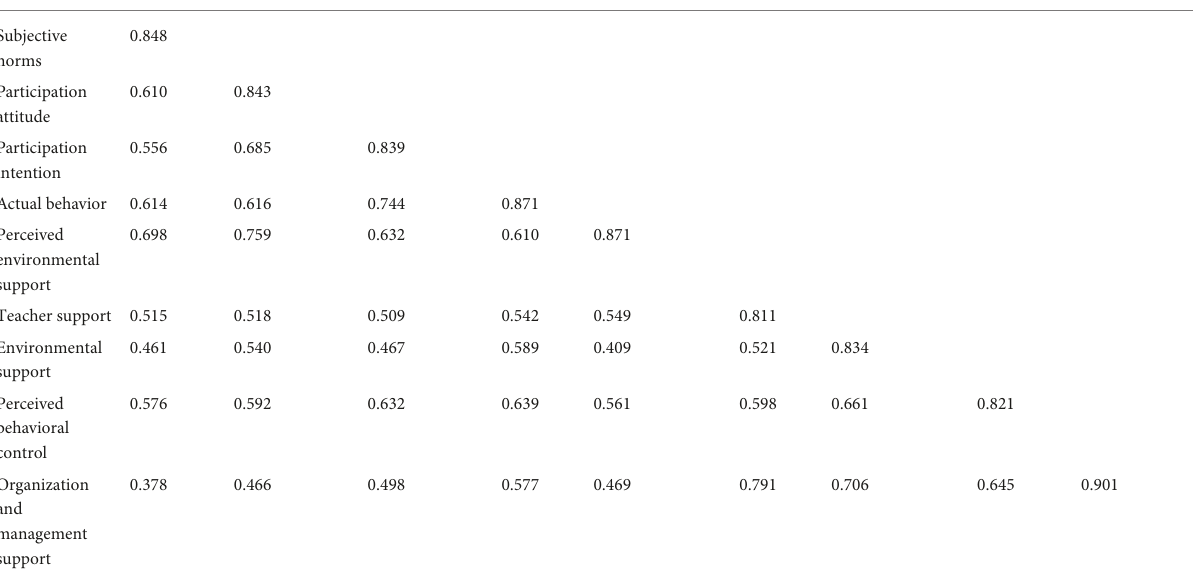
TABLE 6 Differential validity